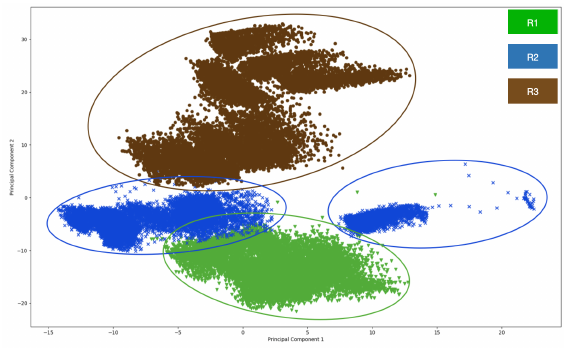
Figure 6. Scatter plot showing RSSI measurements with both missing data imputation and smoothing procedure divided into three classes corresponding to three rooms (R1, R2 and R3).